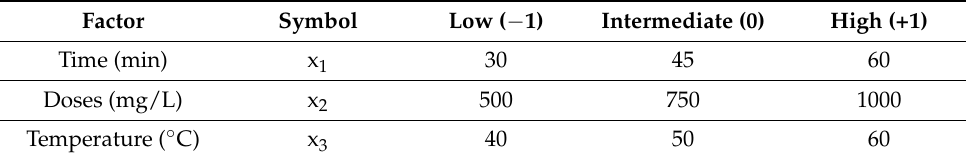
Table 2. Experimental design for the optimization of process